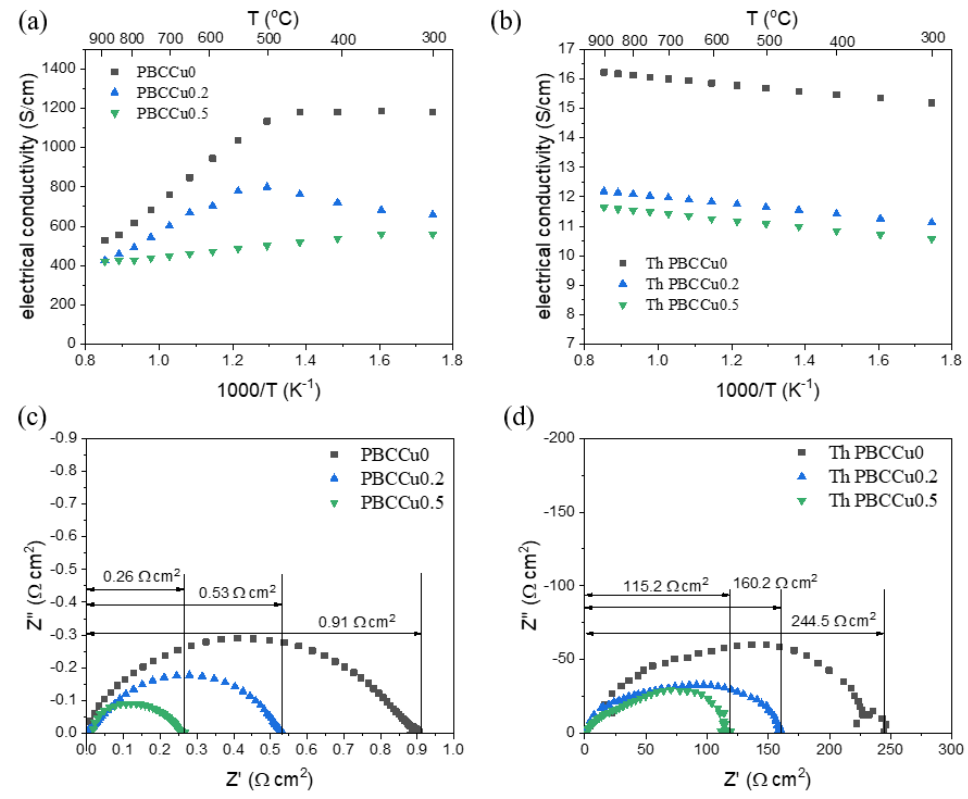
Figure 5. Electrochemical performance of PBCCu x : Electrical conductivity of specimens: ( a ) Pristine and ( b ) After applying thermal stress for 100 h on 1050 °C at 300~900 °C. Polarization resistance of specimens: ( c ) Pristine and ( d ) After applying thermal stress for 100 h on 1050 °C at 600 °C.